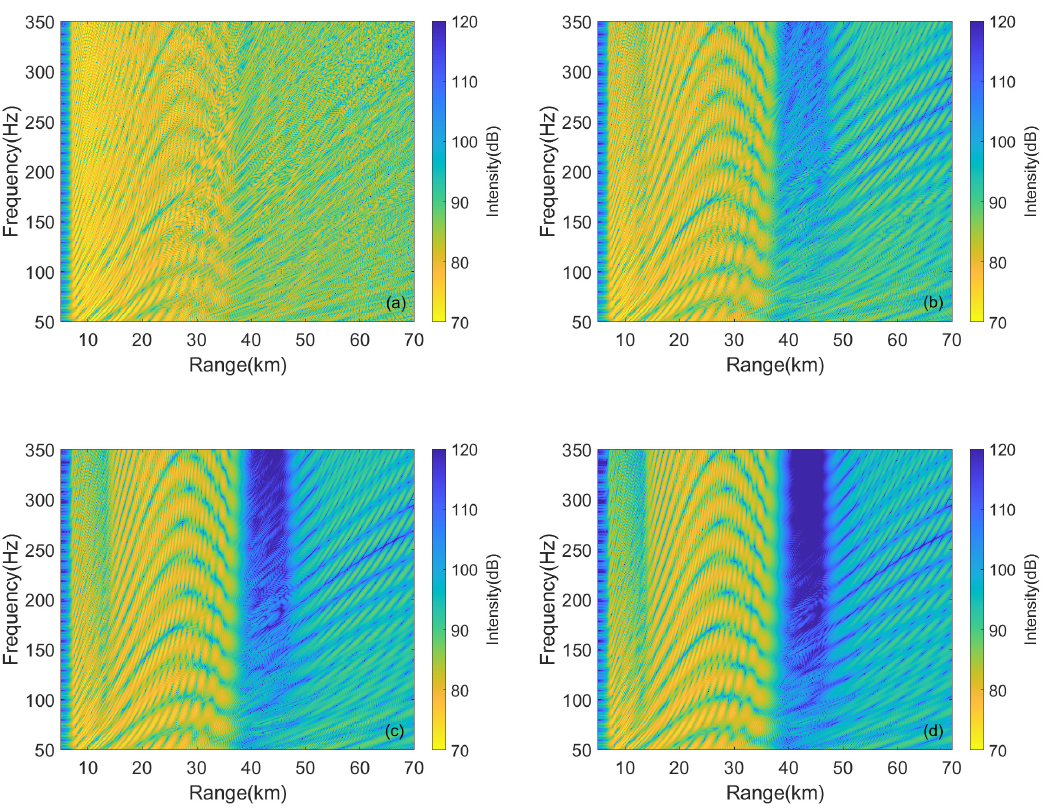
Figure 8. The intensity varies with different attenuation coefficients. ( a ) 0 dB/ λ ; ( b ) 0.2 dB/ λ ; ( c ) 0.4 dB/ λ ; ( d ) 0.6 dB/ λ .